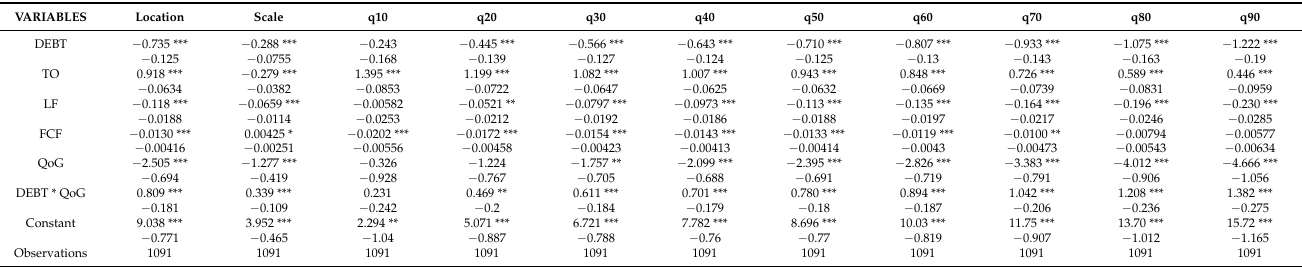
Table 5. The moderating role governance on the nexus between public debt and growth.